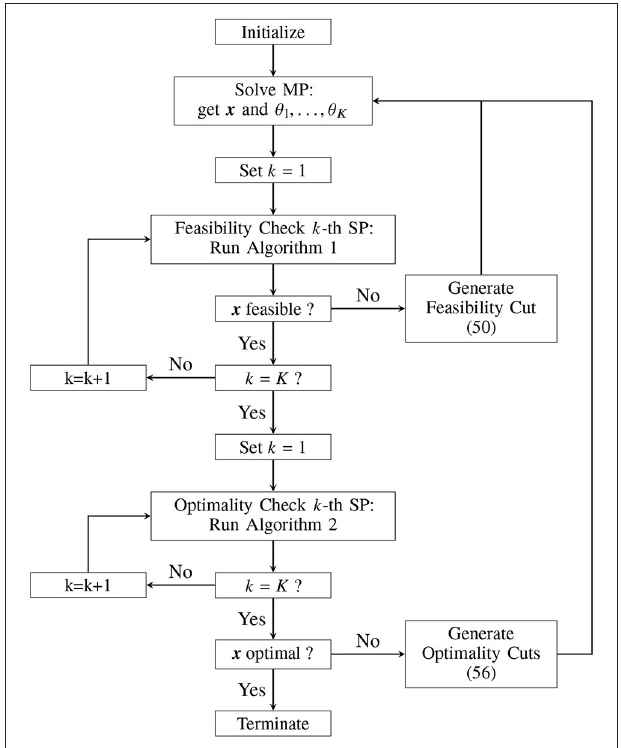
FIGURE 3 | Benders decomposition algorithm to solve HUC from Definition